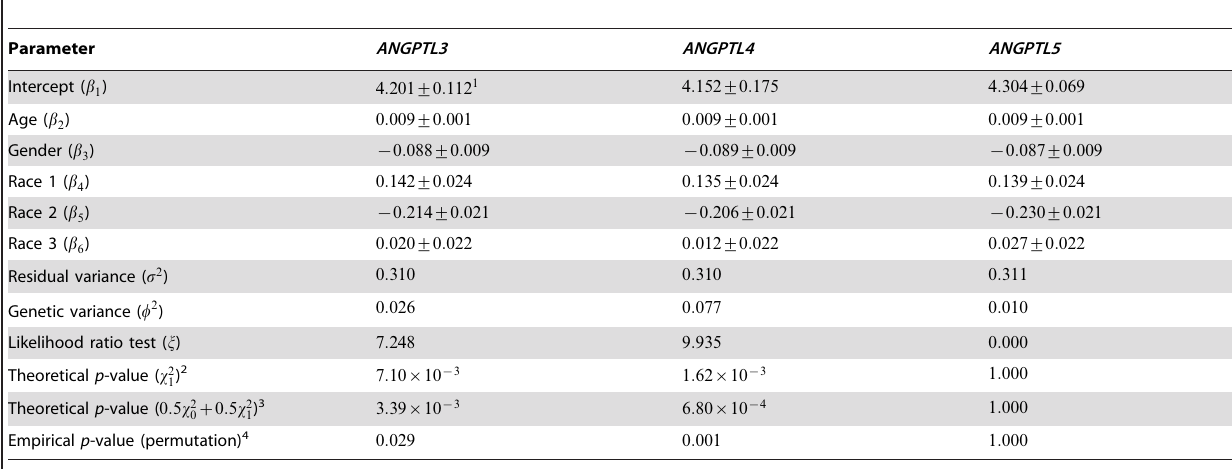
Table 1. Parameters of three genes of the Dallas Heart Study estimated separately using the ARR method proposed in this study.